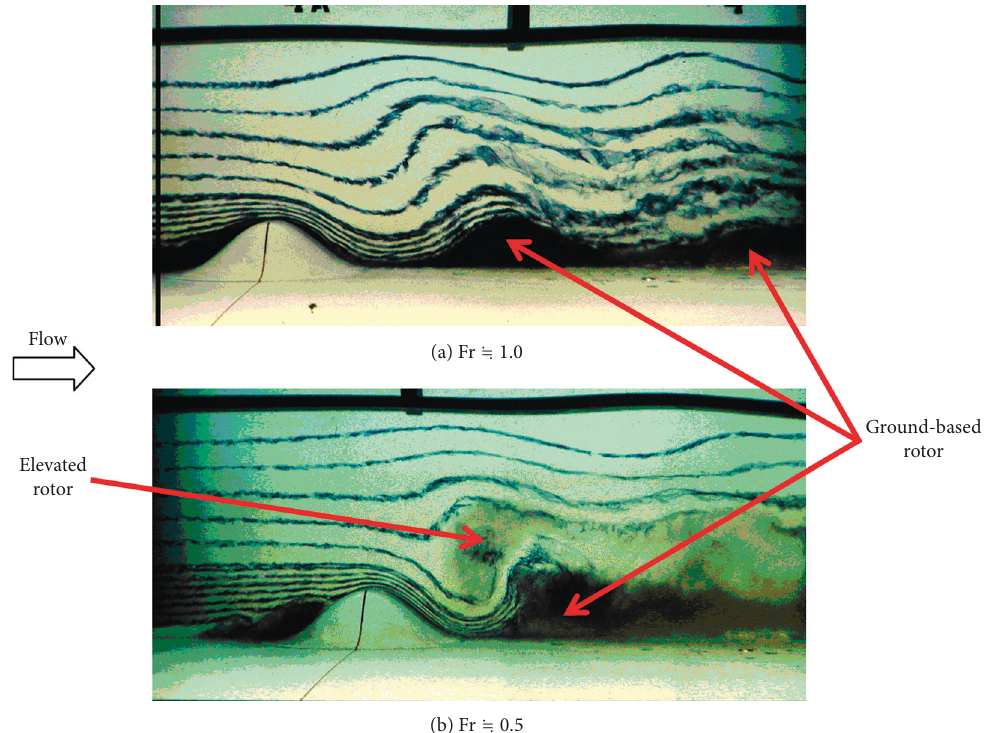
Figure 14: Result of visualization using a towing water tank (Hunt and Snyder [29]).